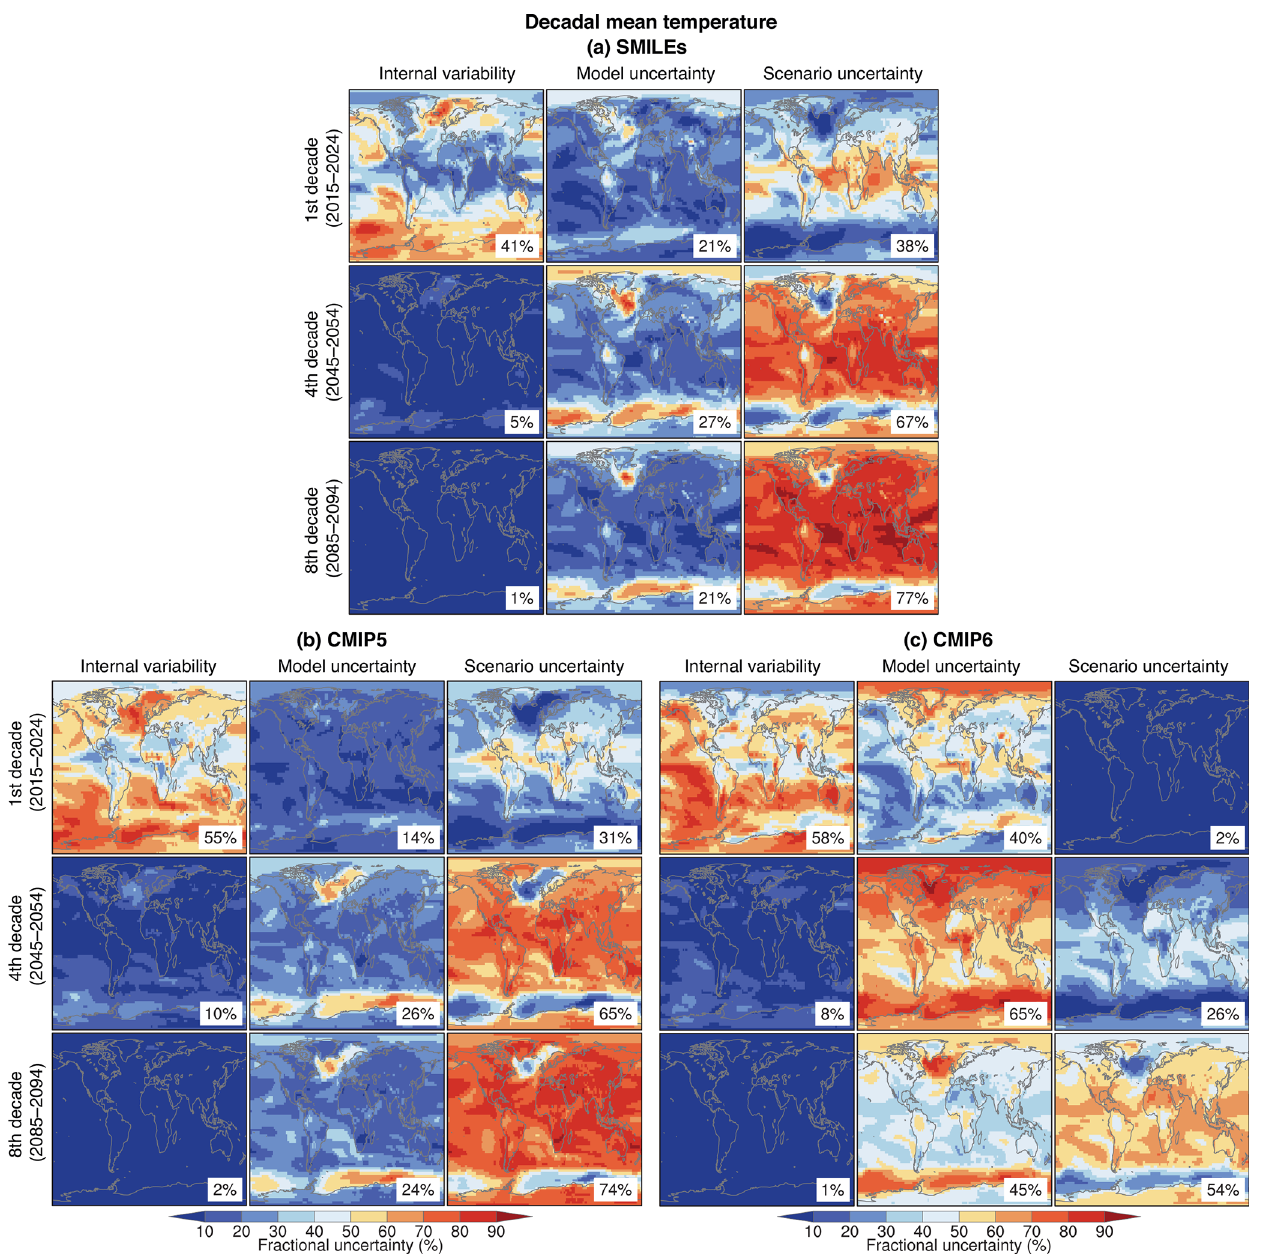
Figure 3. Fraction of variance explained by the three sources of uncertainty in projections of decadal mean temperature changes in 2015– 2024, 2045–2054 and 2085–2094 relative to 1995–2014, from (a) SMILEs, (b) CMIP5 models and (c) CMIP6 models. Percentage numbers give the area-weighted global average value for each